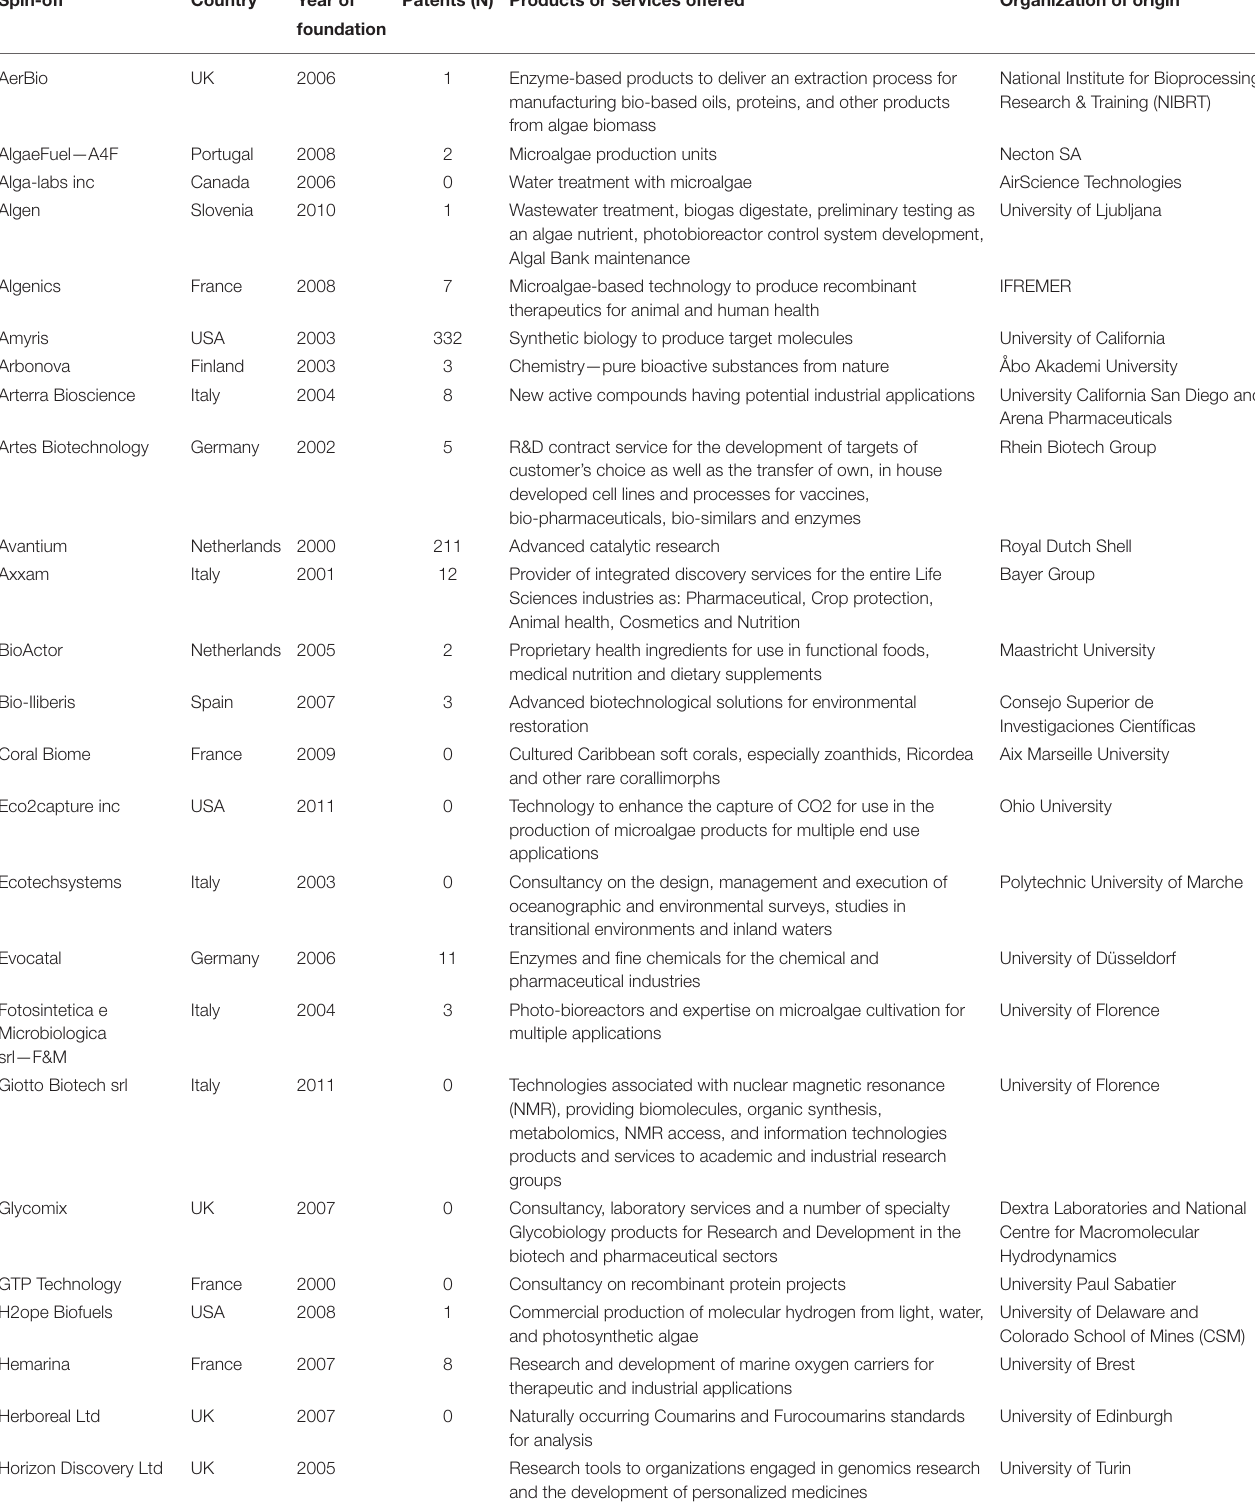
TABLE 3 | The spin-offs of the sample (from 2000 to today).